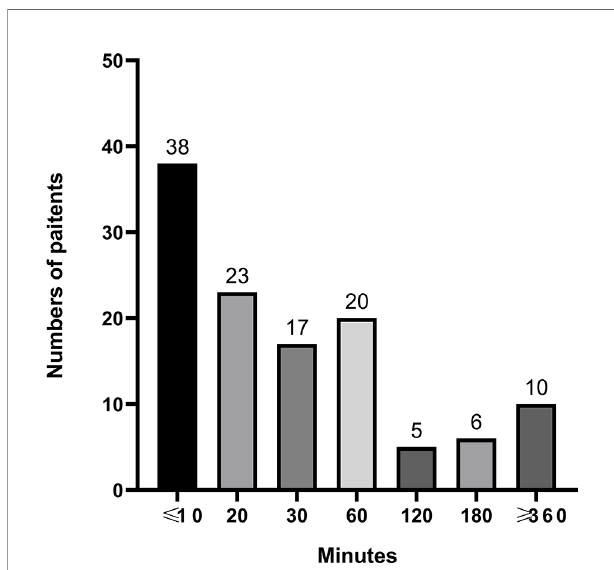
FIGURE 2 | Occurrence time of HSR from the start of OXA